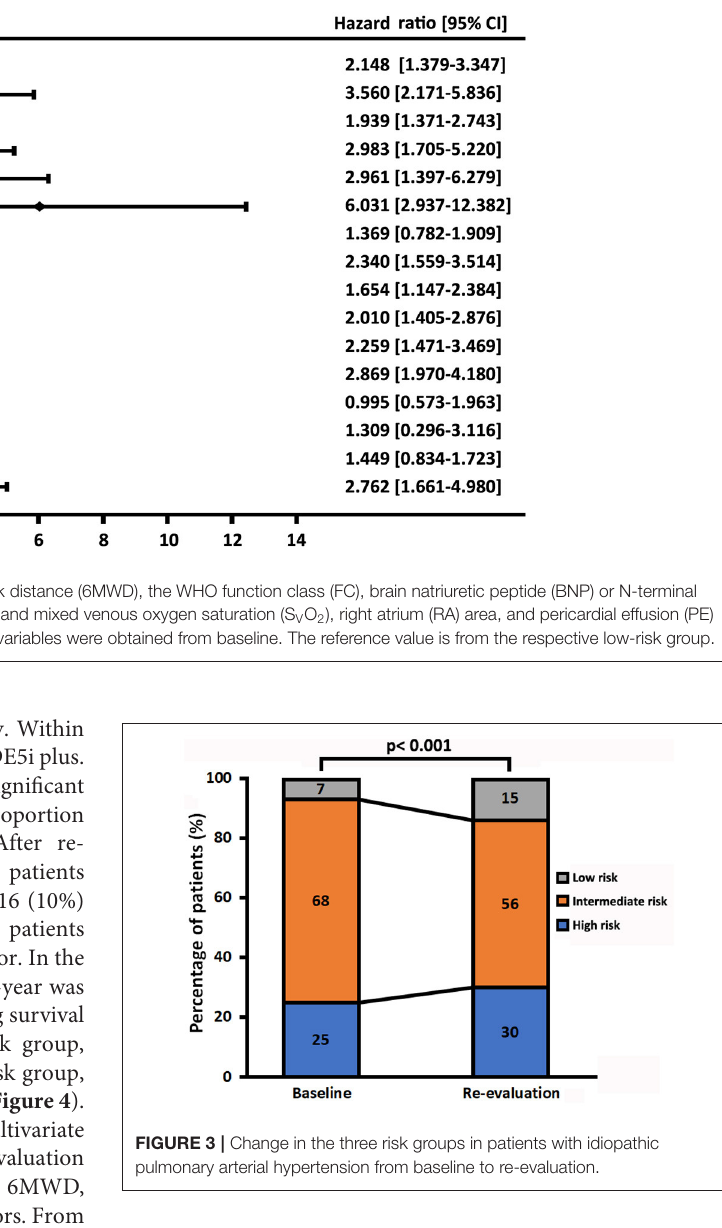
77% in the FPHN, 67% in the COMPERA Registry, and